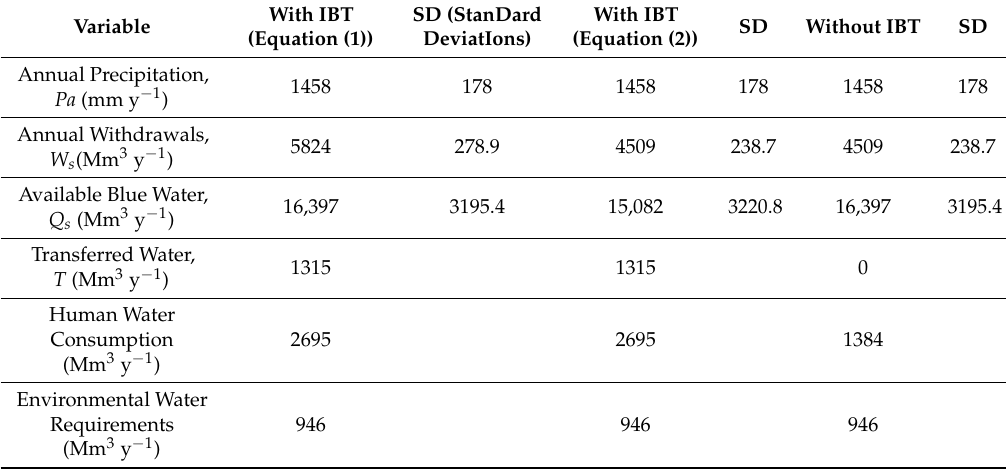
Table 2. Computed local estimates of variables with and without IBT (inter-basin transfer) for the Tone river basin